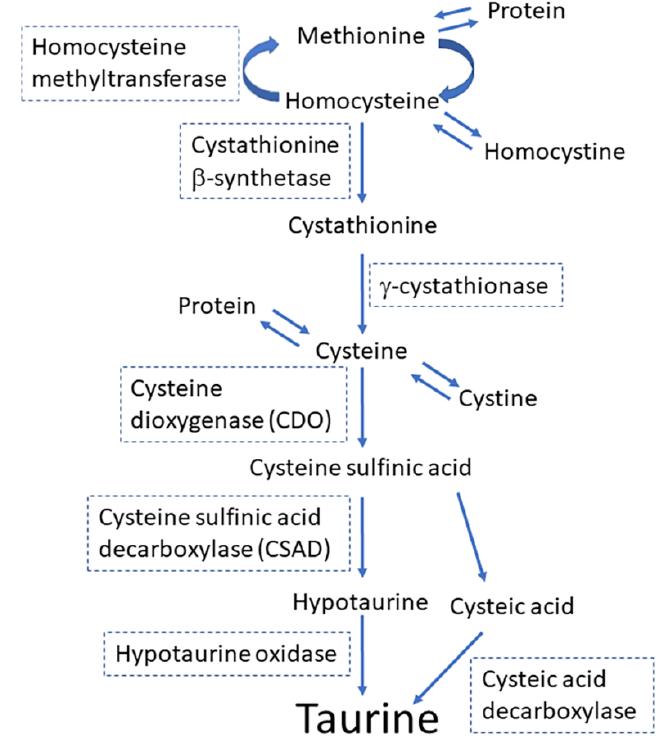
Figure 1. The principal pathway for the synthesis of taurine from methionine and cysteine.